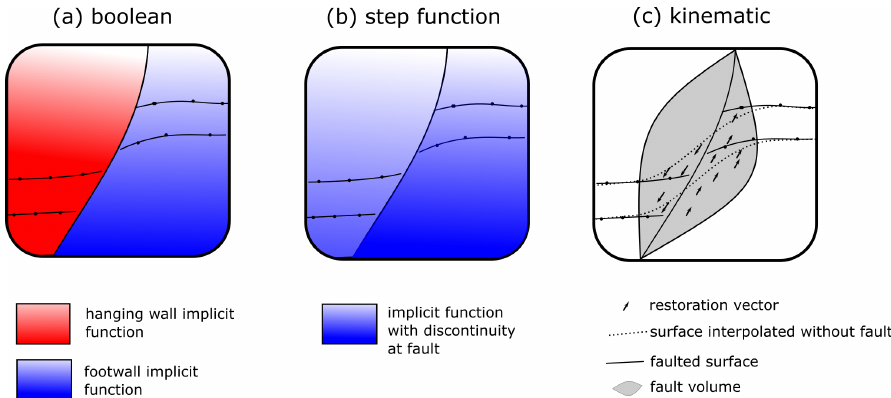
Figure 1. Schematic diagram showing the different approaches for integrating faults into implicit models. (a) The hanging wall and footwall of the fault are represented by two implicit functions (red and blue) where a Boolean operation defined by the fault geometry defines which function is used to represent the geometry. (b) The fault is integrated using a step function in the implicit function where the fault geometry defines the location of the discontinuity. (c) The faulted surface is interpolated without the fault and then restored using the kinematic operator defined by the fault